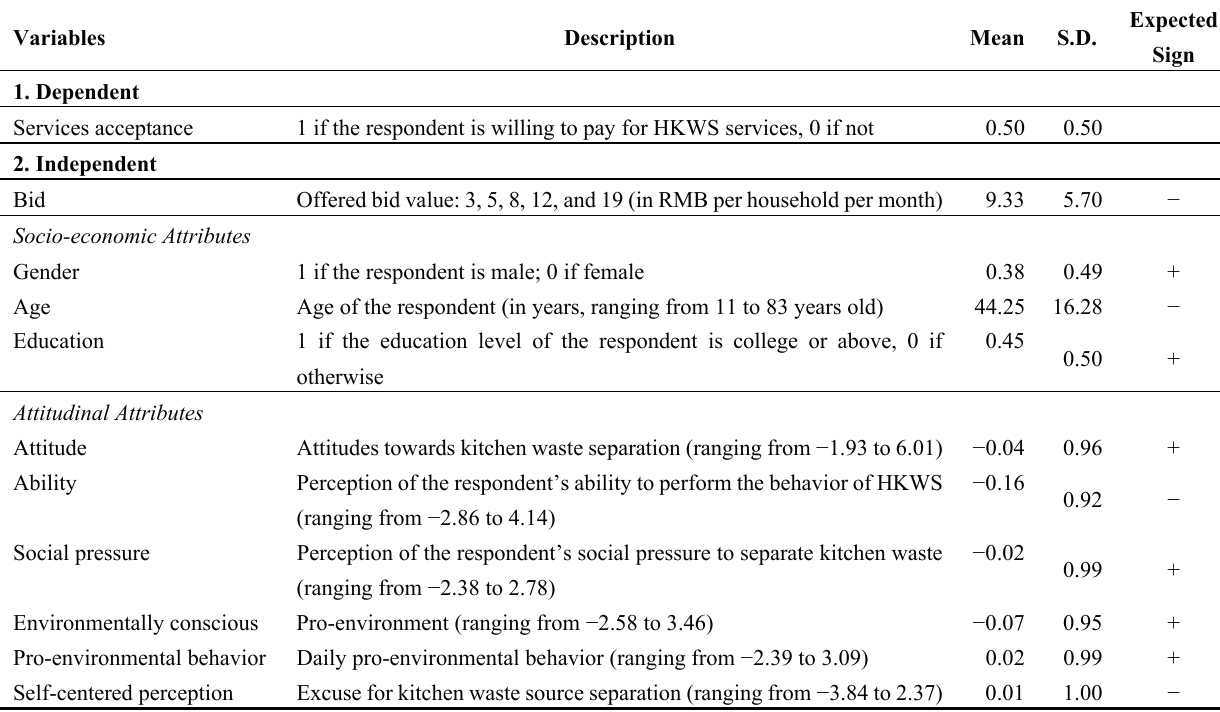
Table 6. Descriptive statistics of the variables used in logistic regression (n =